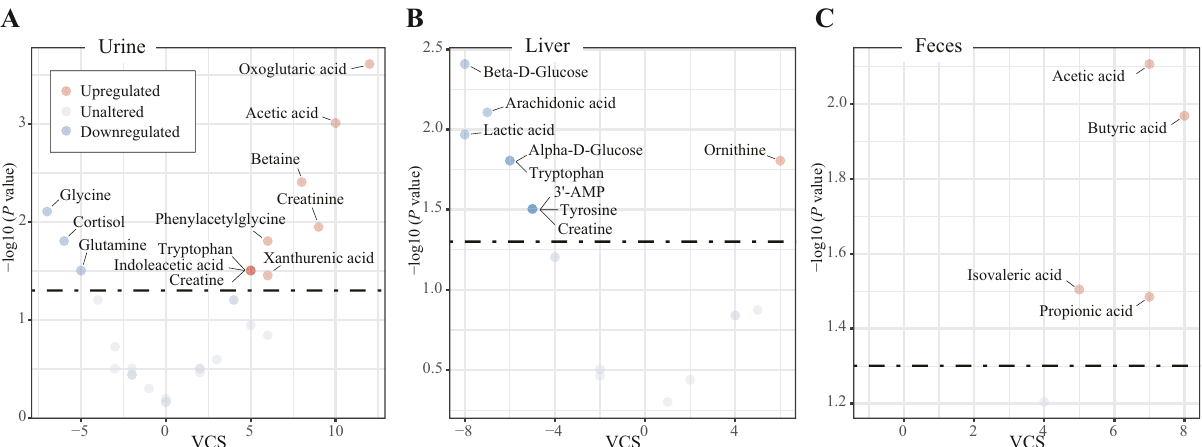
Fig. 3 Effects of pharmacological treatment on metabolite alterations in urine, liver, and feces of depression models. Volcano plot for consistently upregulated (red) and downregulated (blue) metabolites in urine ( A ), liver ( B ), and feces ( C ). The vote-counting statistic (VCS) is presented on the x -axis and the − log10 ( p value) is presented on the y -axis. AMP adenosine